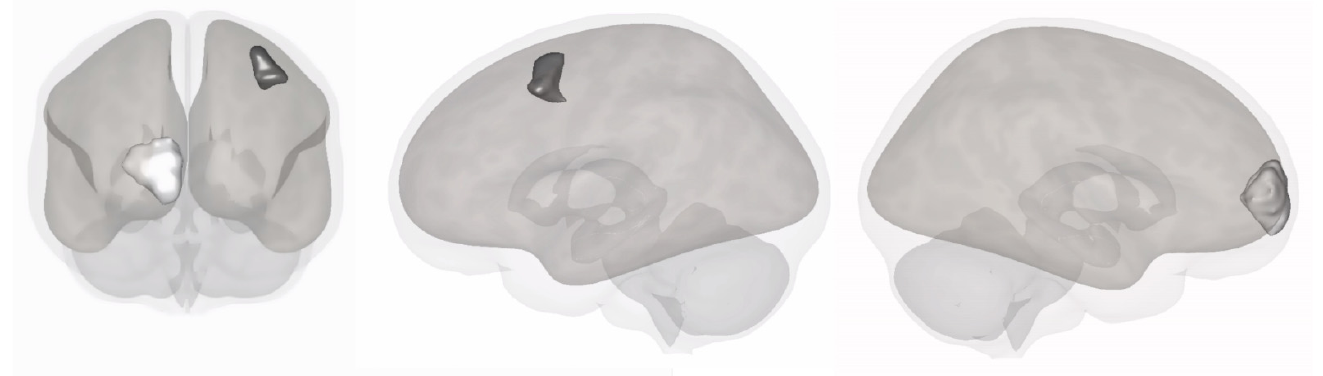
Figure 3. DLPFC regions that presented a significant regional cerebral blood flow change after tDCS.